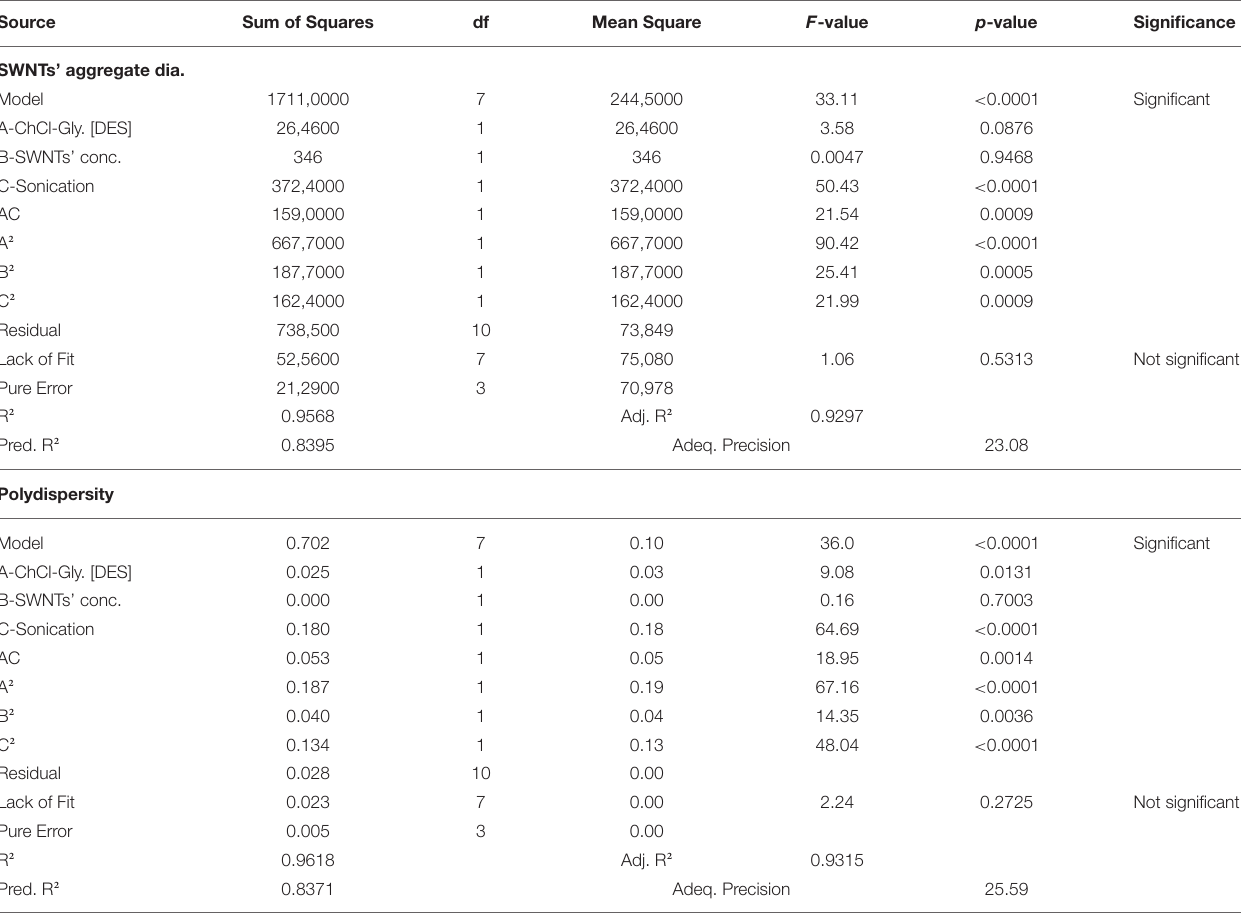
TABLE 4 | ANOVA of models developed for SWNTs aggregate diameter and polydispersity in the aqueous ChCl-Gly DES system. Source Sum of Squares df Mean Square F -value p